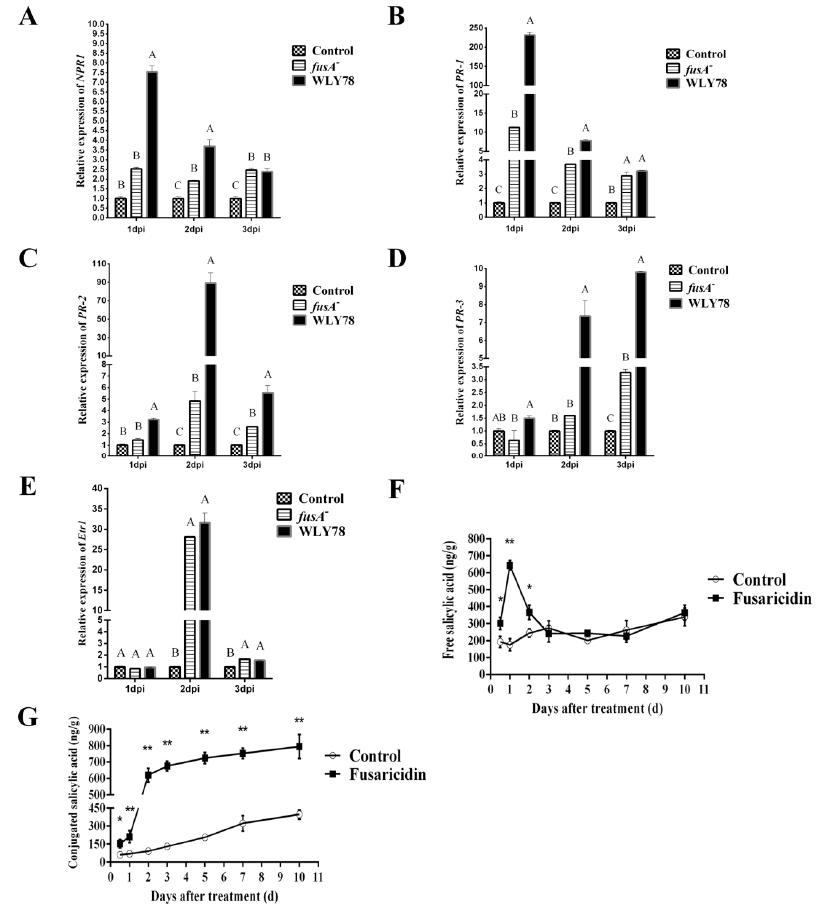
Figure 6. Relative expression levels of genes NPR1 ( A ), Etr1 ( B ), PR1 ( C ), PR2 ( D ), and PR3 ( E ) in leaves of P. polymyxa WLY78, the fusA ‐ mutant, and water treatment at days 1, 2. and 3. Accumulation of free salicylic acid ( F ) and conjugated salicylic acid ( G ) in roots was induced by fusaricidin. Different letters or asterisks indicate significant differences at p < 0.01, according to the Duncan multiple range test. Error bars indicate standard deviations among triplicates.